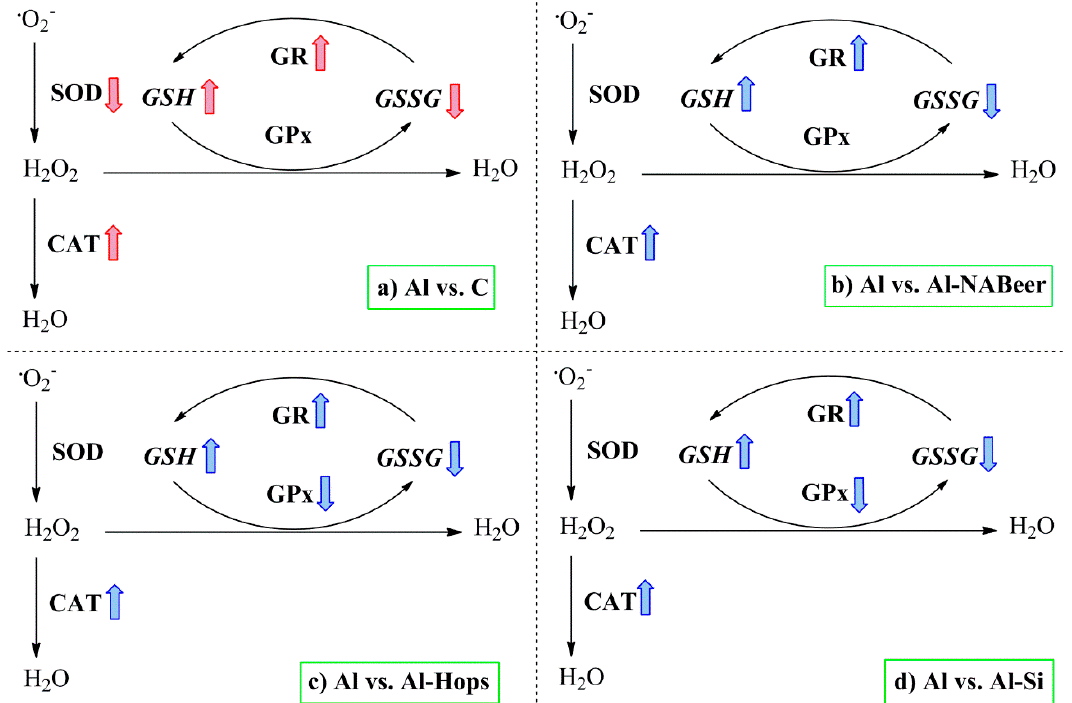
Figure 8. Summary of the main e ff ect of aluminum intoxication on the antioxidant enzymes’ activities and expressions in the rats’ brains [123]. Colored arrows indicate significant di ff erences caused by the aluminum-treated group when compared to the experimental groups. CAT, catalase; SOD, superoxide dismutase; GR, glutathione reductase; GPx, glutathione peroxidase; GSH, reduced glutathione; GSSG, oxidized glutathione. Subsections: ( a ) comparison between the Aluminium intoxicated group with their control counterparts; ( b ) comparison between the Aluminium intoxicated group with the Aluminium + Non-alcoholic beer group; ( c ) comparison between the Aluminium intoxicated group with the Aluminium + Hops extract group; ( d ) comparison between the Aluminium intoxicated group with the Aluminium + Silicon group.